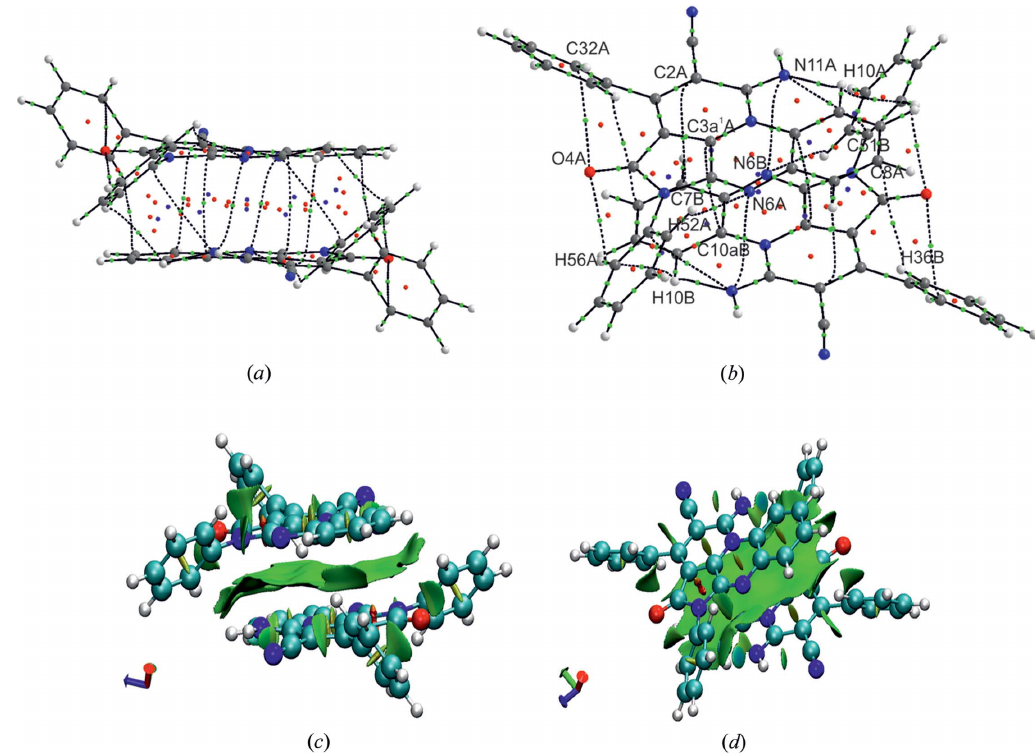
Figure 4 Molecular graph of TAAP with marked critical points: bond critical points (bcp), ring critical points (rcp) and cage critical points (ccp): ( a ) showing a side view and ( b ) a top view. NCI analysis of the intramolecular interactions in the TAAP dimer: ( c ) showing a side view and ( d ) a top view. The blue colour on the plot represents the bonding interaction region, green surfaces represent van der Waals interactions and red surfaces are the non-bonding